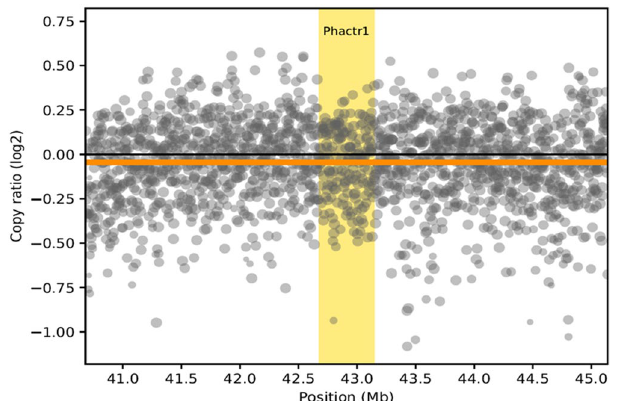
Figure 4. Copy number variant plot (CNV) plot across Phactr1 locus based on genome sequencing data from BCCAS mice with different vascular phenotypes: three BCCAS mice with two very prominent PcomAs and ECA retrograde flow, which did not develop any ischemic lesion detectable on T2-weighted MRI both 1 and 7 days post-surgery (Fig. 2BI) and 3 BCCAS mice with no PcomAs and ECA retrograde flow,which developed severe hemispheric lesions and died within a few hours-one day post-surgery (Fig.